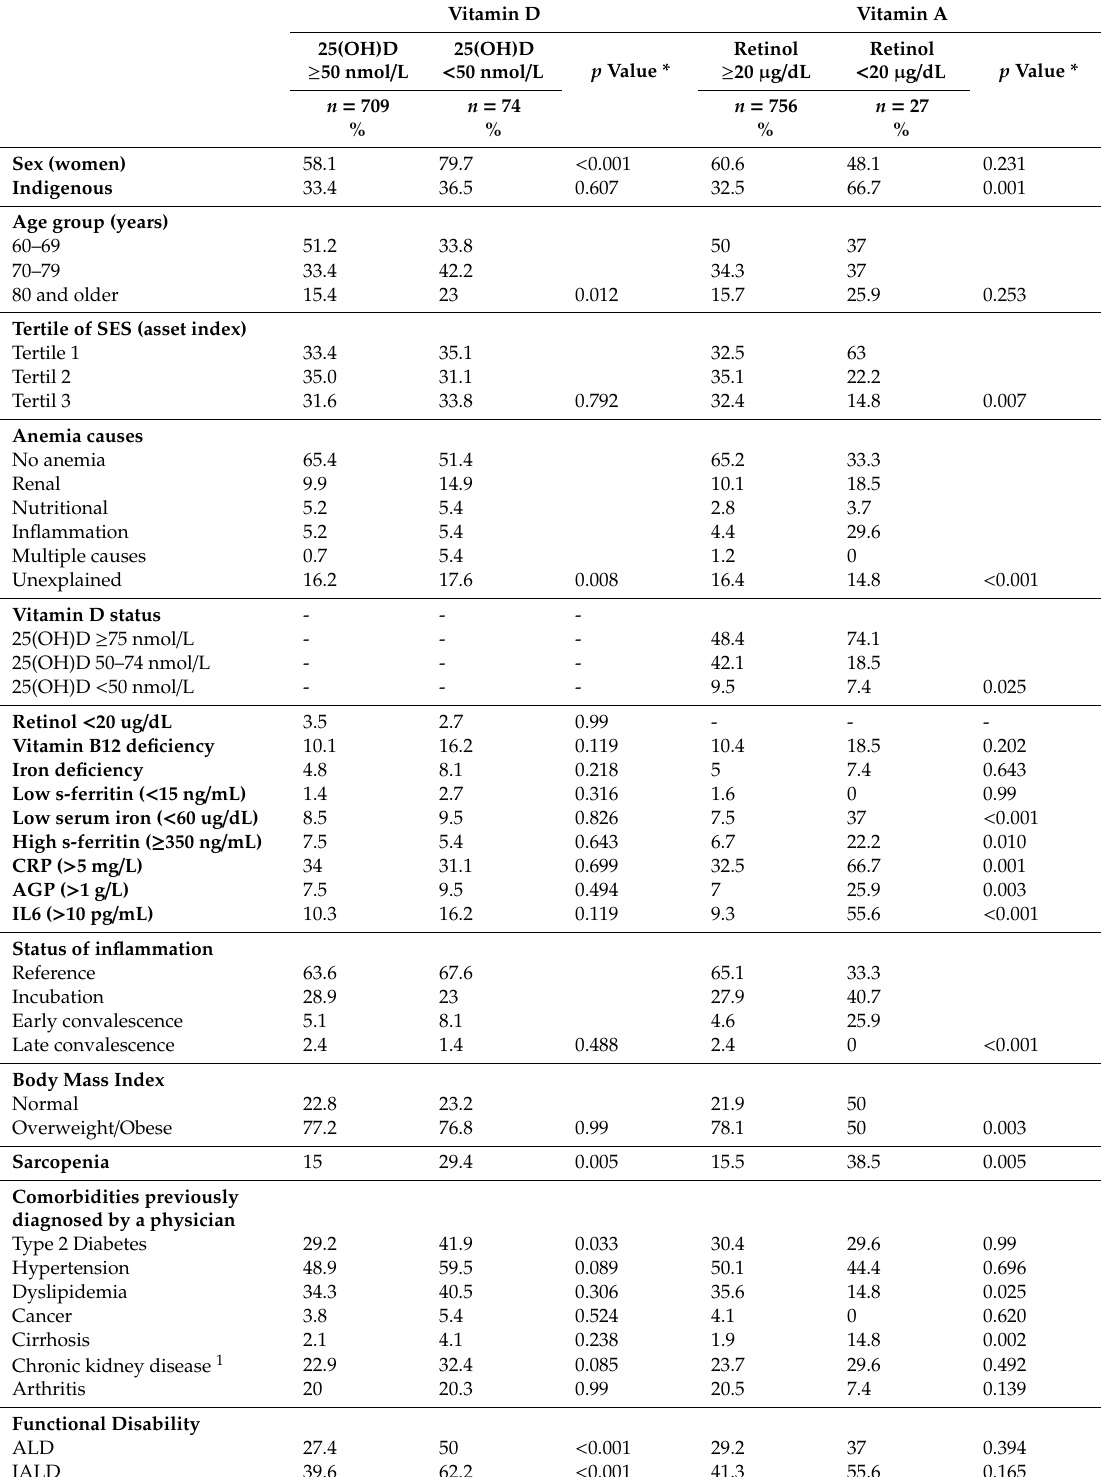
Table 2. Frequency of characteristics of Mexican older adults by vitamin D and vitamin A status. Vitamin D Vitamin A 25(OH)D 25(OH)D < 50 nmol / L ≥ 50 nmol / L